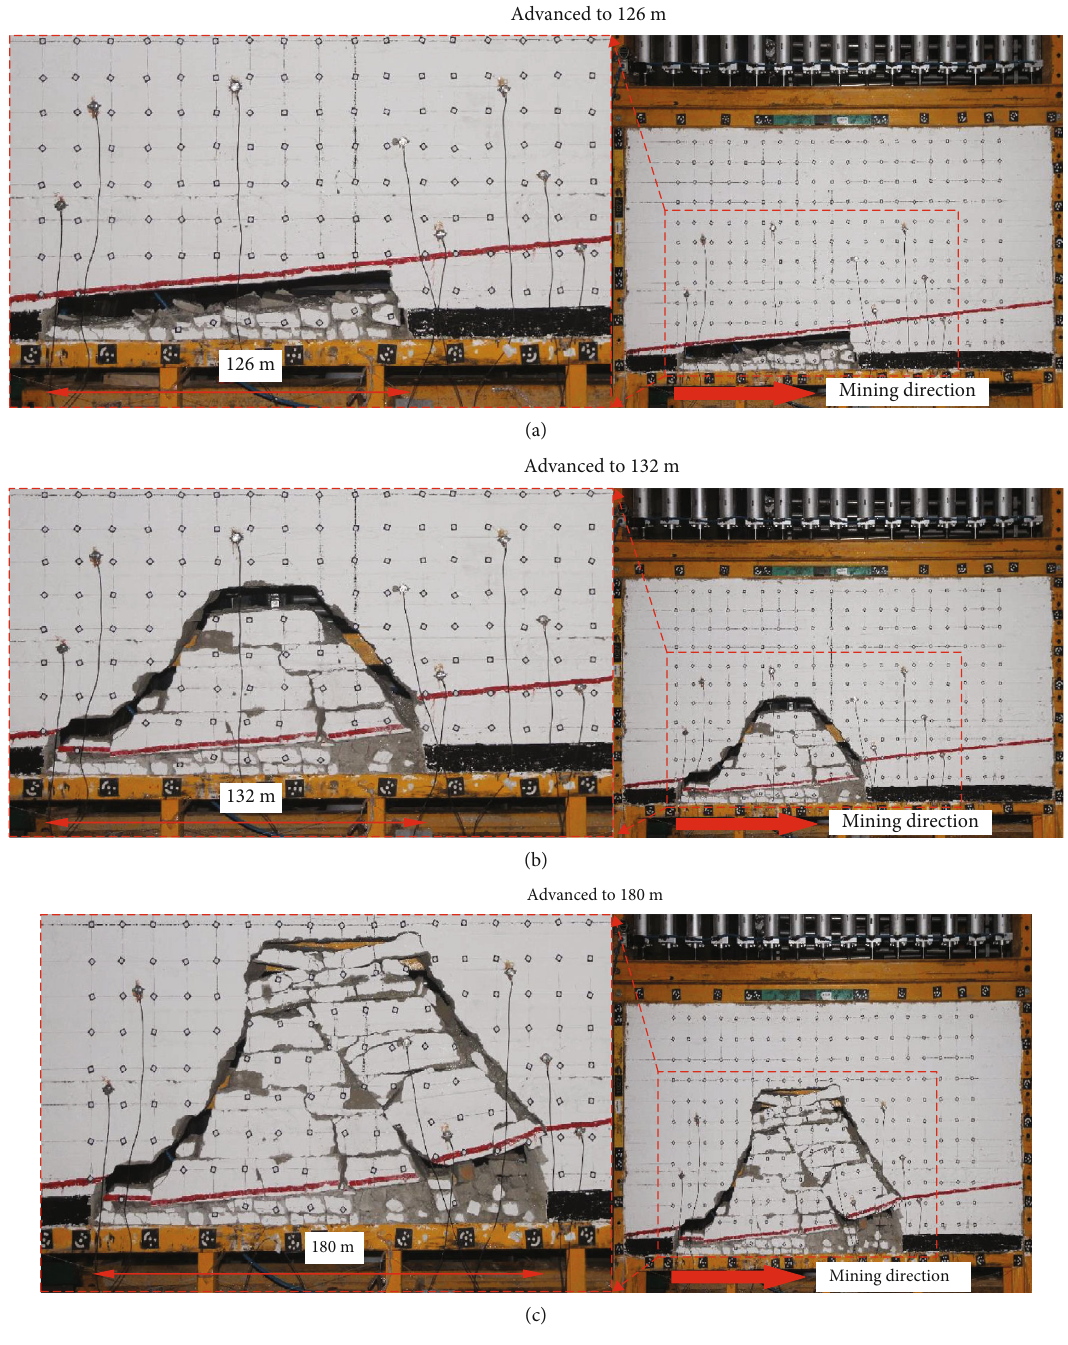
Figure 3: Instability structure of overlying strata in